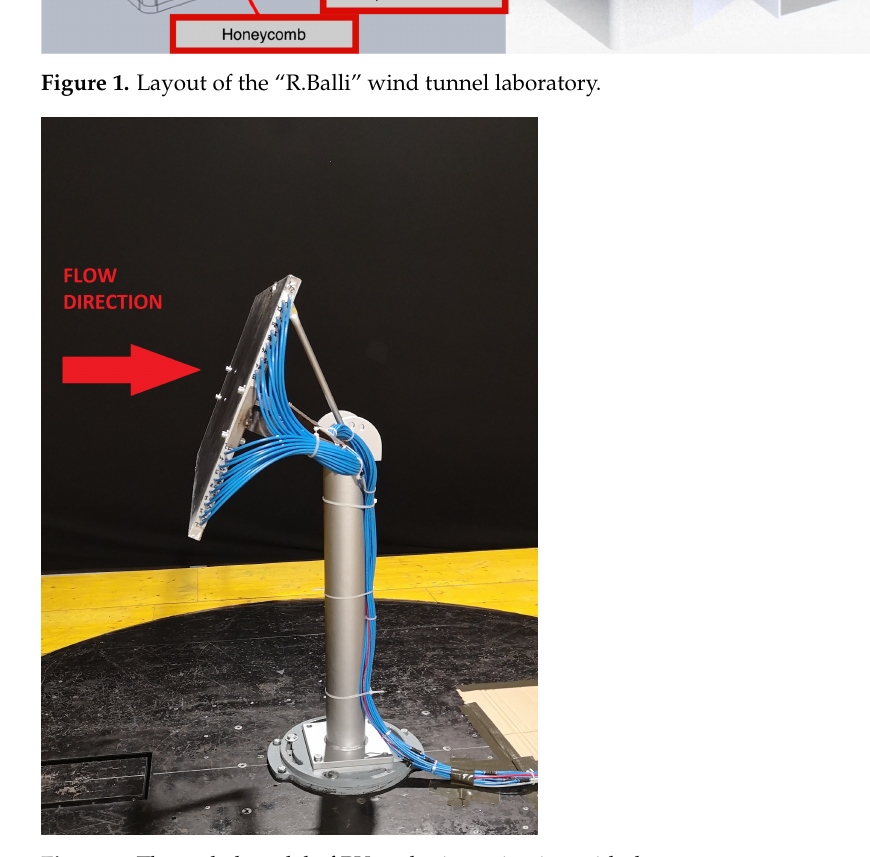
Figure 2. The scaled model of PV under investigation with the pressure measurement